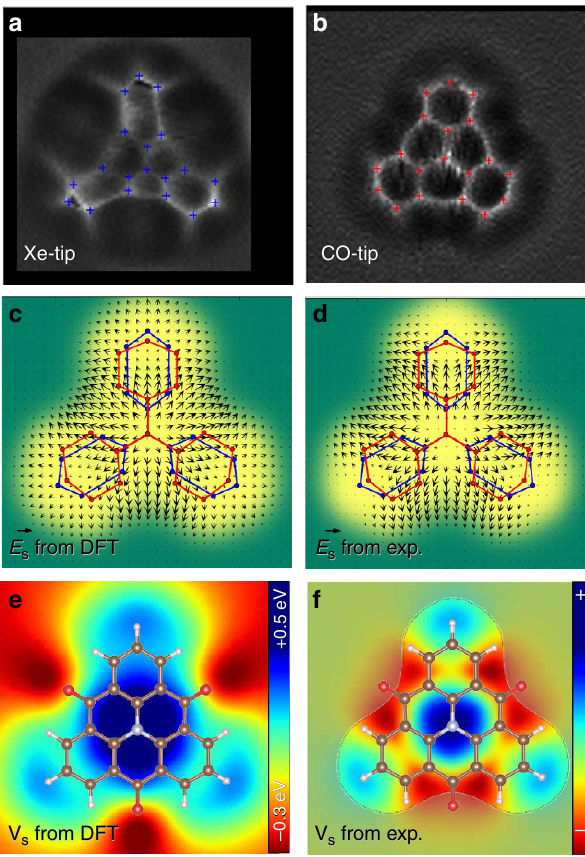
Figure 4 | Determining the electrostatic field above an individual molecule. ( a ) High-pass filtered constant-height AFM images of a TOAT molecule on Cu(111) acquired with a Xe tip. Crosses indicate characteristic vertices. ( b ) Same as a but measured with a CO tip. ( c ) electrostatic force field calculated from DFT. ( d ) experimentally determined electrostatic force field obtained after subtraction of the van der Waals component from the deformation field obtained from the images shown in a and b . ( e ) calculated Hartree potential; ( f ) electrostatic potential calculated from the experimental deformation field shown in d